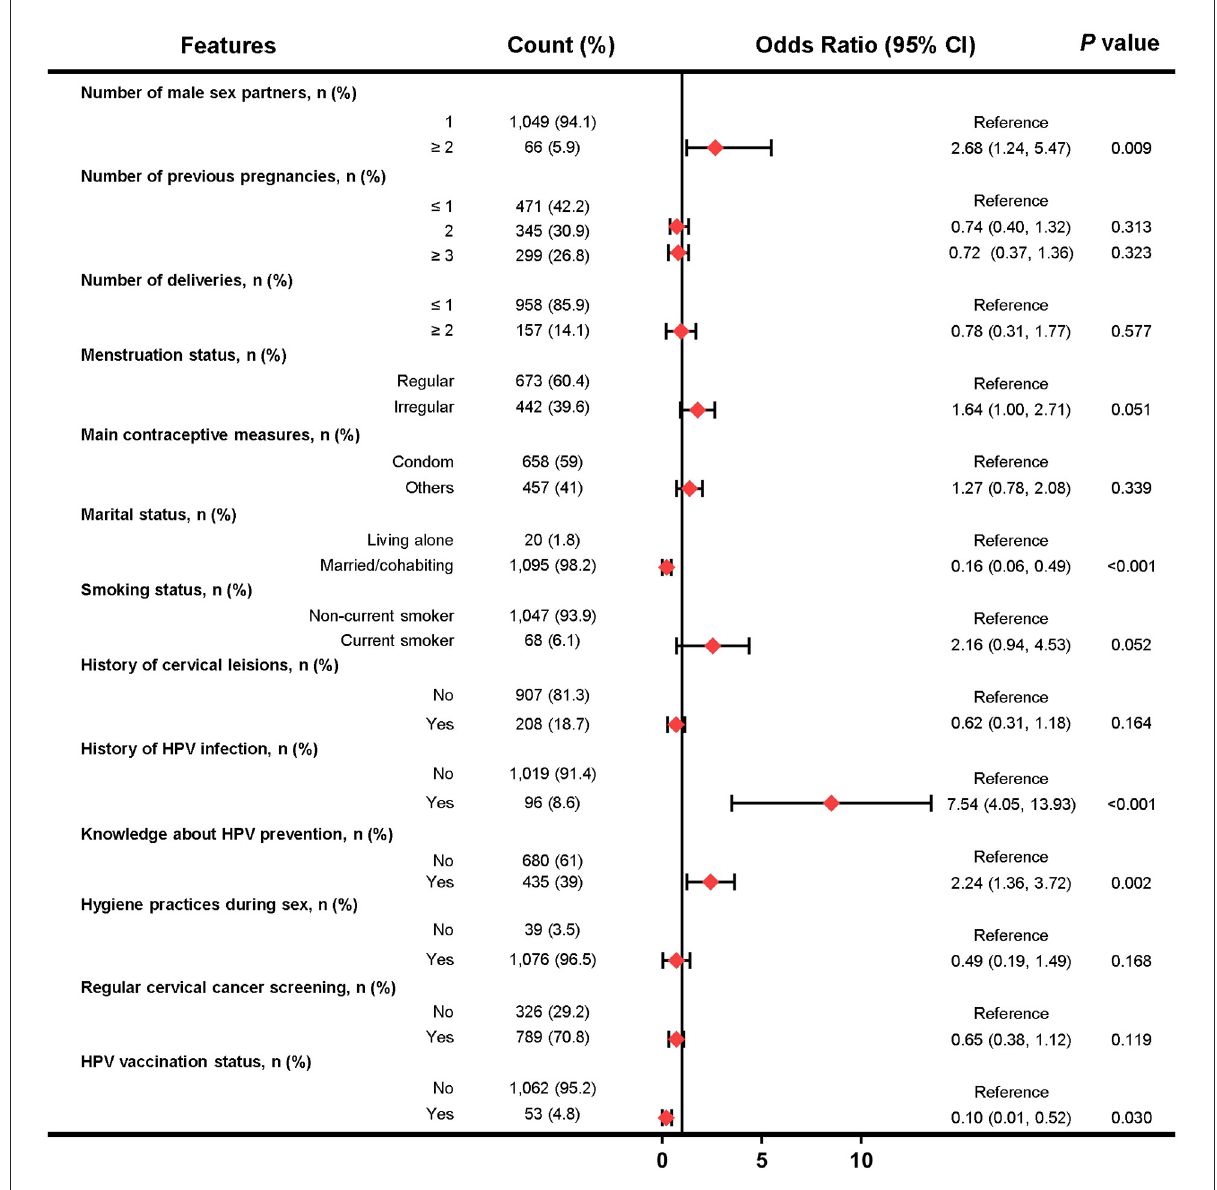
FIGURE4 Forest plot of multivariable logistic regression analysis in the training set of Beijing female cohort. The x-axis represents the odds ratio scale. An odds ratio > 1 indicates increased odds of HPV infection, whereas an odds ratio < 1 suggests decreased odds of HPV